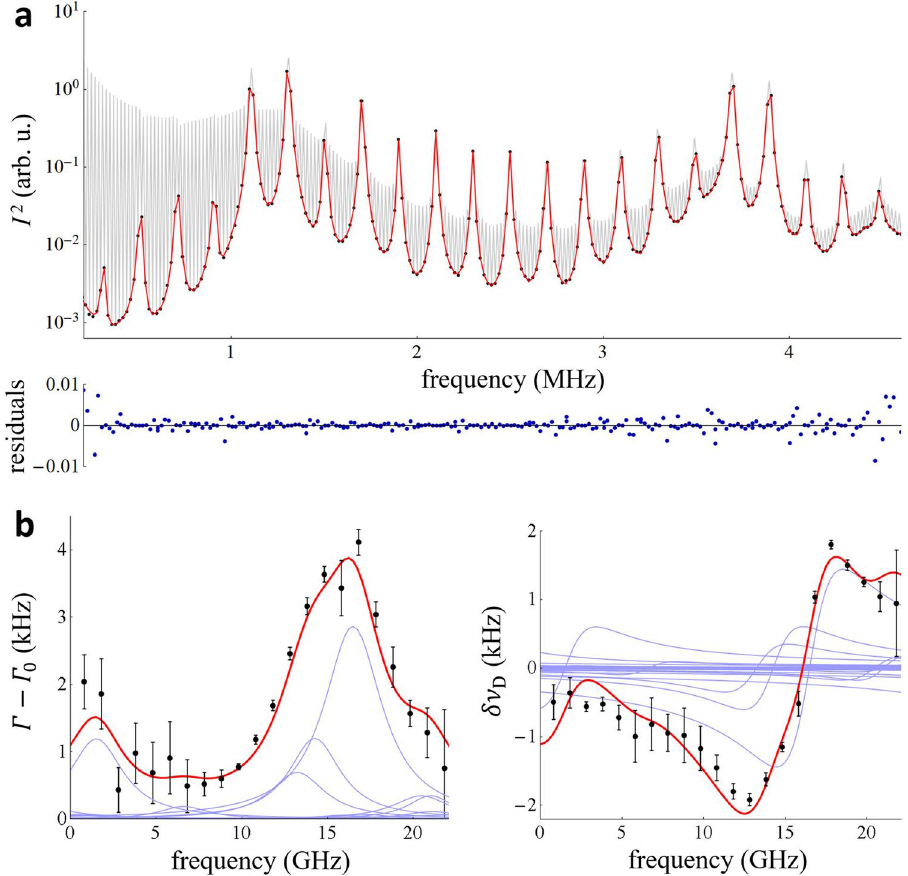
Figure 3. Molecular spectra measured by coherently driven cavity excitation. ( a ) Fourier spectrum of the down-converted ring-down signals (gray line). An average of 1500 spectra from consecutive 100- µ s-long ring- down signals is shown. Selection of even multiples of f m leads to clean cavity mode spectra comprising 10 points per mode (black points). The fitted mode shapes are shown as red lines. Below, the ratio of the fit residuals to the mode peaks is shown as blue points. ( b ) Absorption (left plot) and dispersion (right plot) spectra of methane (black points) retrieved from the measured cavity mode widths and positions. An offset of 191,605.777 GHz has been subtracted from the optical frequency axis, and the error bars correspond to three times the measured ensemble standard deviation at each spectrum detuning. The methane spectra calculated using line shape parameters from HITRAN2016 are shown as the red lines with individual transitions shown as blue lines. The overall intensity was fitted simultaneously to both the measured absorption and dispersion spectra. For the absorption spectrum, the fitted background, corresponding to the empty cavity losses of 6.30(12) kHz, was subtracted from the plot. Likewise, for the dispersion case, the fitted linear background was subtracted from the